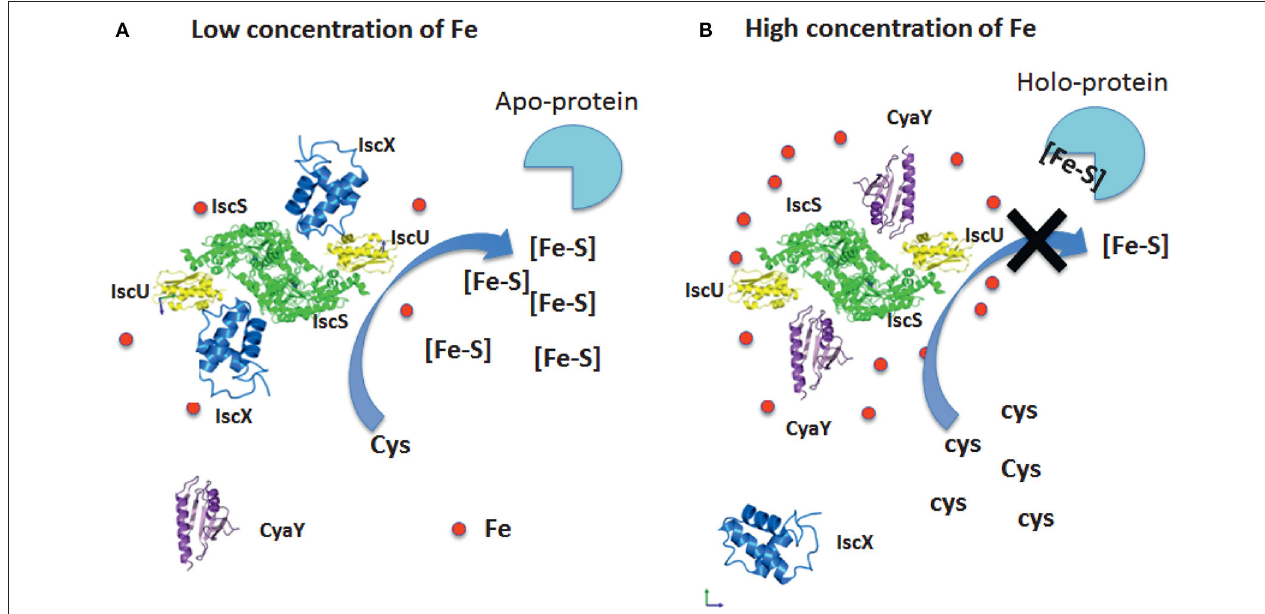
FIGURE 8 | Model of the relative roles of CyaY and IscX. (A) At low iron concentrations, the system is under the control of IscX, which fills the binding site and impedes binding of CyaY. (B) At high iron concentrations, the system becomes under the control of